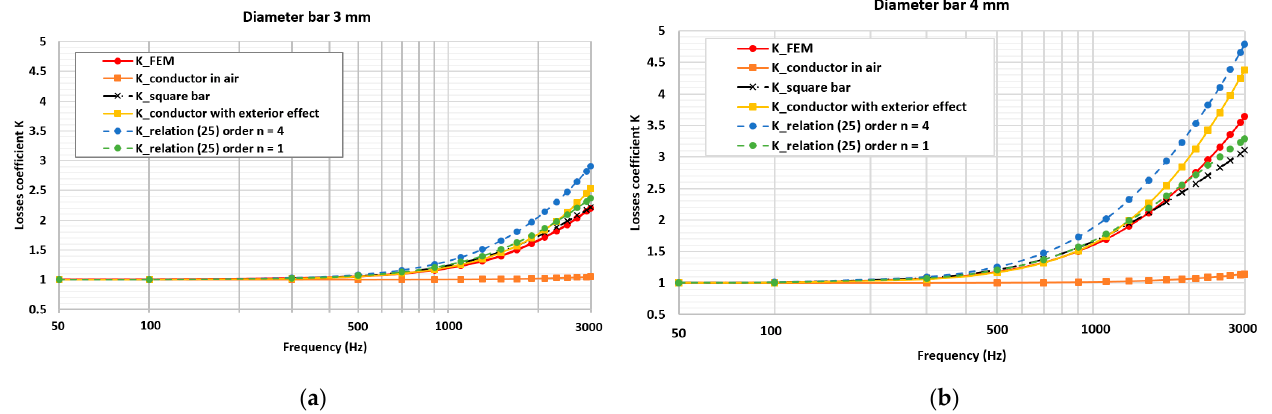
Figure 14. Losses coefficient as a function of frequency ( a ) R = 1.5 mm, ( b ) R = 2 mm.